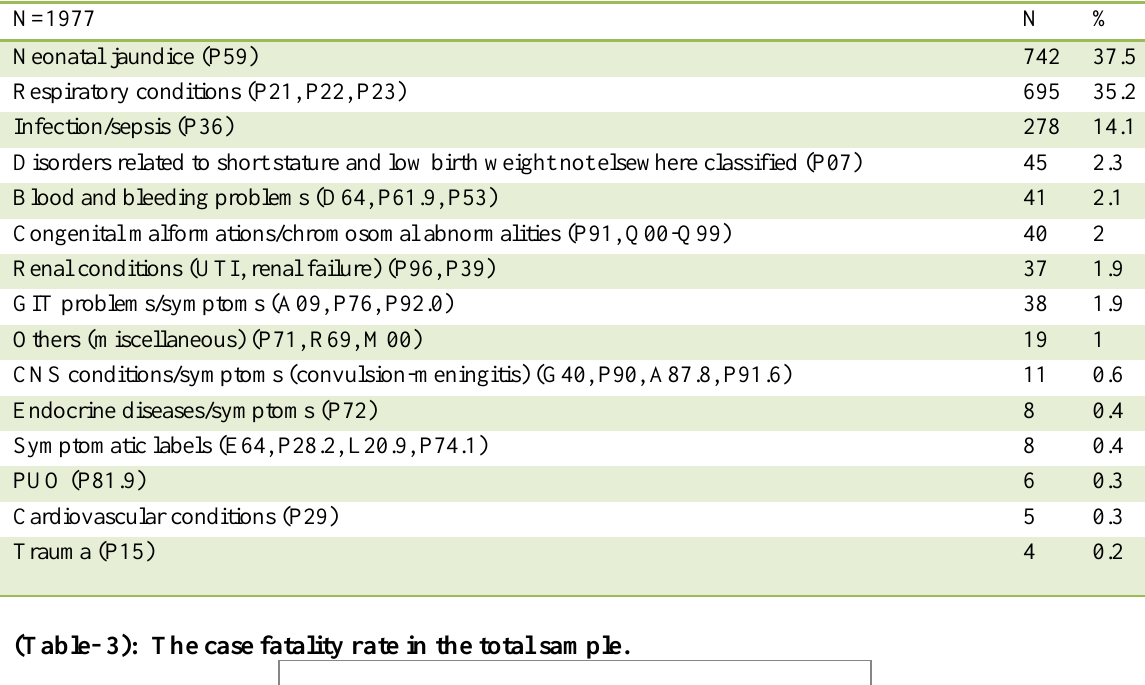
(Table-2 ): Relative frequency for selected categories of cause of admission.